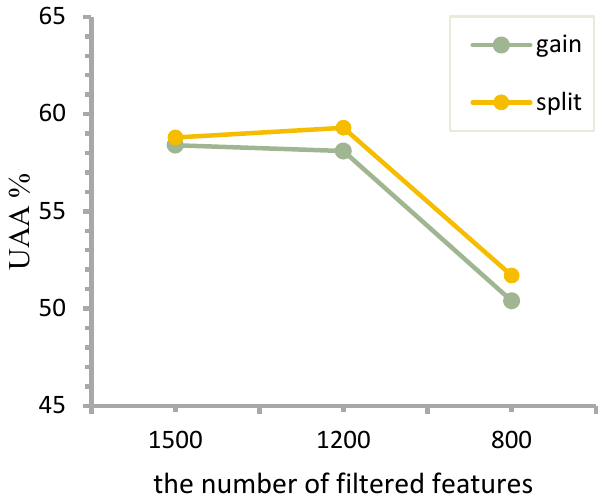
Figure 7. Classification performance of feature subsets obtained using two feature selection methods.